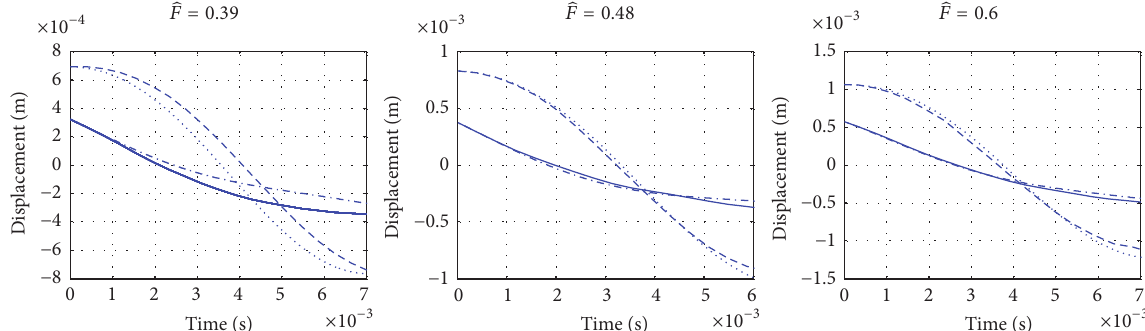
Figure 21: Comparison of the free vibration response of the beam system with the analytical solutions to estimate the value of friction. Solid line: response at the end of the primary beam (sensor 2). Dashed line: response at the end of the secondary beam (sensor 3). Dash-dotted line: free vibration response of the primary mass response with friction estimated. Dotted line: free vibration response of the secondary mass response with friction estimated.